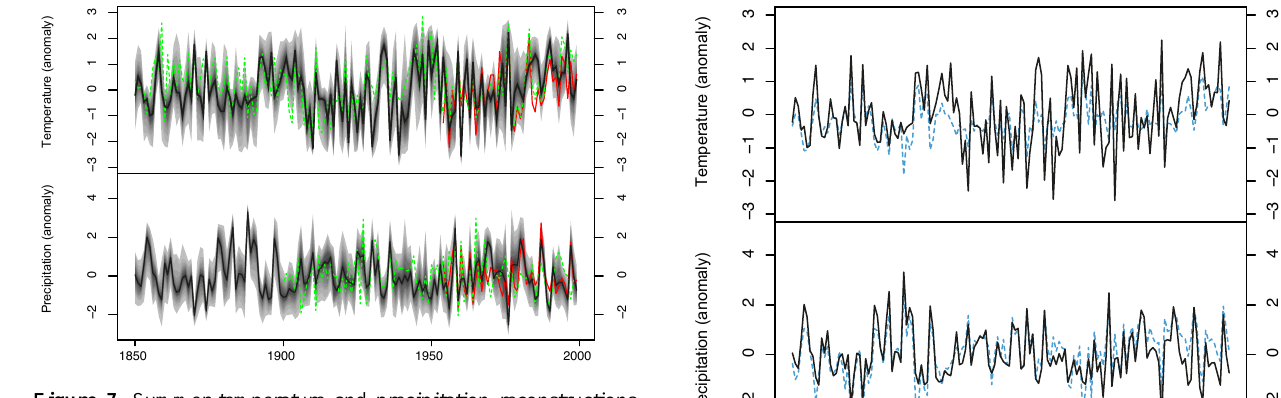
Figure 7. Summer temperature and precipitation reconstructions back to ca. 1850. Reconstructed climatic conditions (black) are compared to the CRU (green) data during the common period. Ob- servations during the 1960–1999 period are in red. The quantiles between 2.5 and 97.5 fall within the gray shading. Figure 8. Comparison between two reconstruction techniques: the inversion of MAIDENiso (black) and the transfer function (dashed blue) calibrated for the 1960–1999